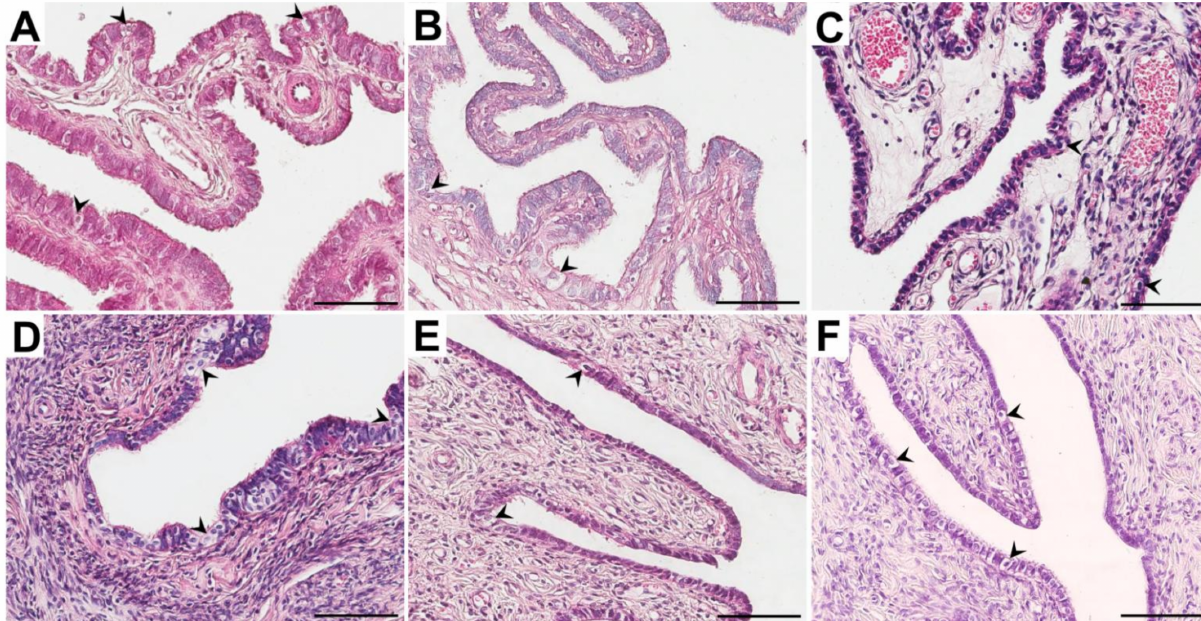
Figure 1. Representative light micrographs of the hematoxylin and eosin-stained ampulla ( A – C ) and isthmus ( D – F ) of the fallopian tubes in postmenopausal women for whom 1–5 years ( A , D ), 6–10 years ( B , E ) and ≥ 11 years ( C , F ) had elapsed between the last menstrual period and surgery. Note that in the glandular epithelium, vacuolization was observed (black arrowheads). Scale bar—50 µ